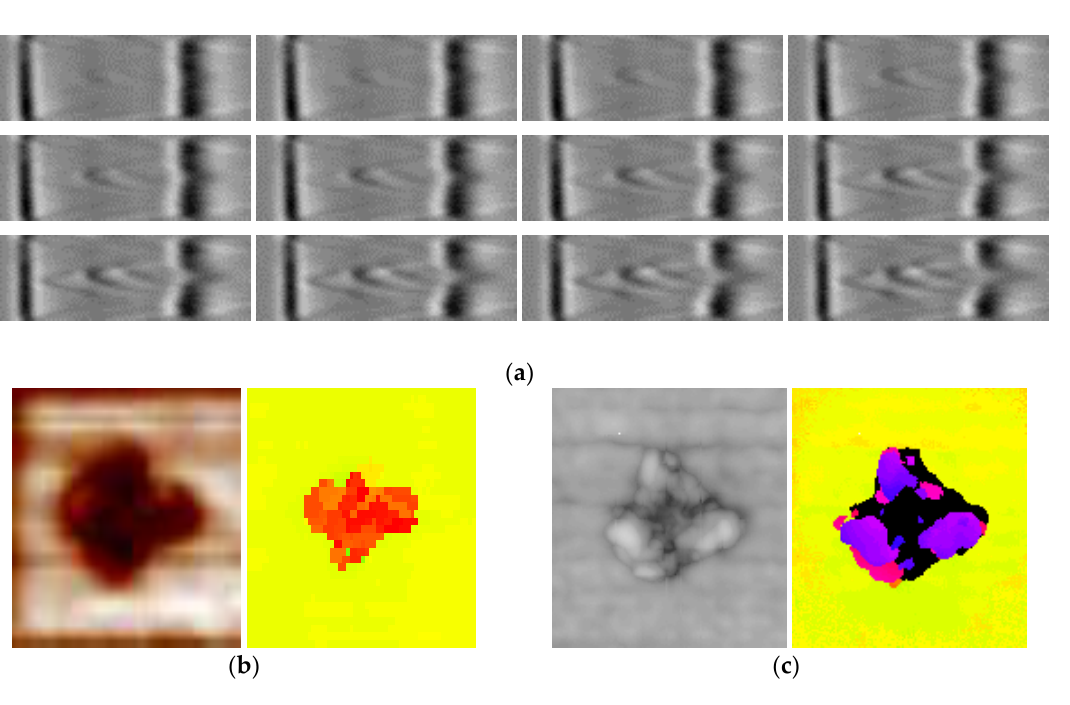
Figure 4. Ultrasonic testing (UT) results: ( a ) the representative set of UT B-Scans (nos. 54÷65 from 170 in total); amplitude and Time-of-Flight (ToF) C-Scans obtained using ( b ) phased-array, and ( c ) pulse-echo methods.